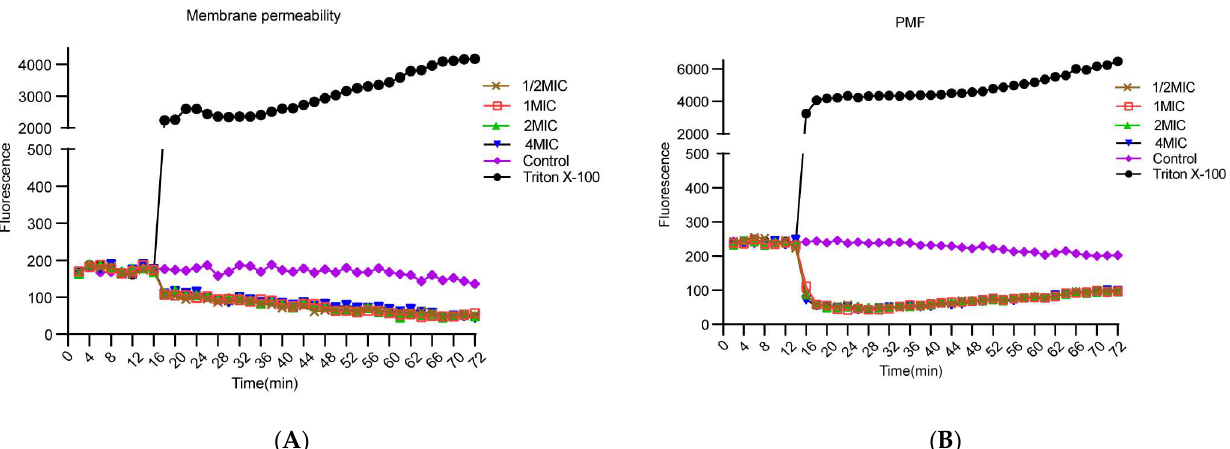
Figure 4. PIC on the proton motive force and the membrane permeability of S. aureus ATCC 29213. ( A ) Dynamic fluorescence of PI-treated S. aureus ATCC 29213 following the addition of PIC. ( B ) Dynamic fluorescence of Disc3(5)-treated S. aureus ATCC 29213 following the addition of PIC. n = 3. Results from all experiments are presented as the mean ± SD of three replicates.